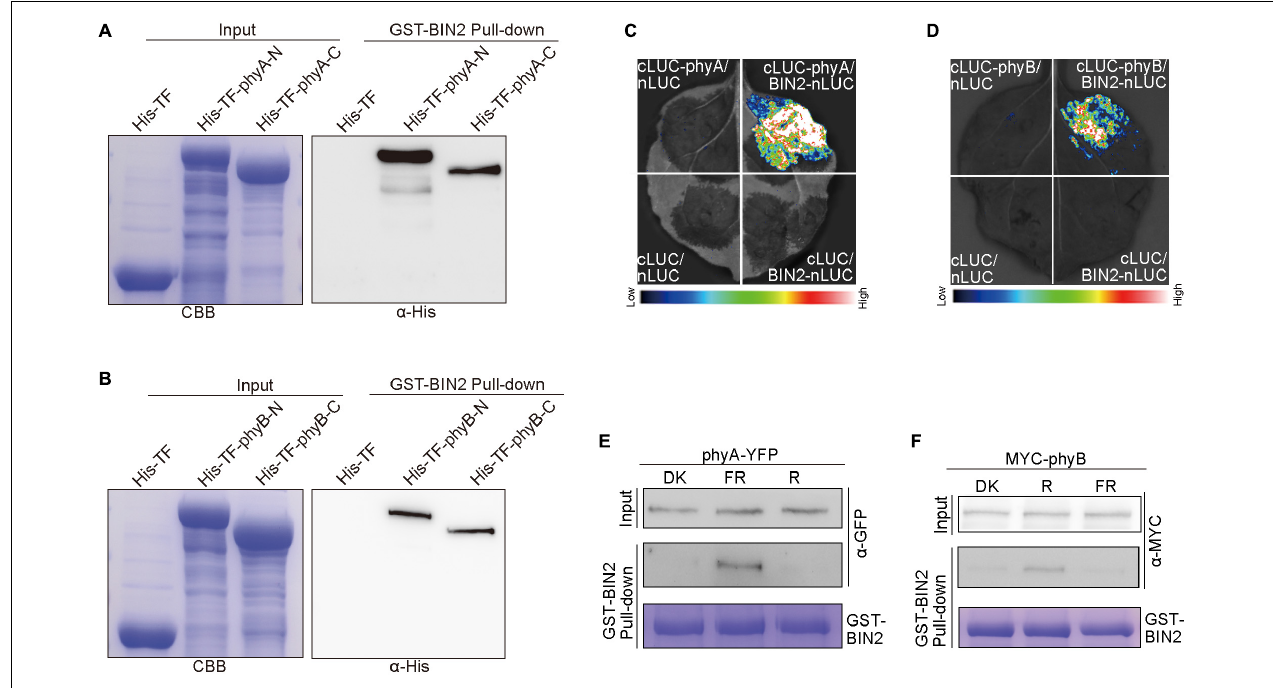
FIGURE 5 | phyA and phyB interact with BIN2. (A,B) His pull-down assays showing the interactions of phyA-N, phyA-C (A) , phyB-N and phyB-C (B) with BIN2. GST-BIN2 served as a bait. His-TF-phyA-N, His-TF-phyA-C, His-TF-phyB-N, His-TF-phyB-C, and His-TF served as preys. The preys were detected with α -His antibody. (C,D) Split-LUC assays showing the interactions of phyA (C) and phyB (D) with BIN2. The vectors expressing nLUC and/or cLUC served as negative controls. (E,F) Semi- in vivo GST pull-down assays showing far-red and red light-dependent interactions of phyA (E) and phyB (F) with BIN2, respectively. GST-BIN2 served as a bait. The protein extracts prepared from phyA-YFP-OX and Myc-phyB-OX seedlings served as preys. phyA-YFP-OX and Myc-phyB-OX seedlings were grown in dark for 5 days, and then exposed to far-red light (FR, 10 µ mol/m 2 /s) and red light (R, 50 µ mol/m 2 /s) for 30 min,